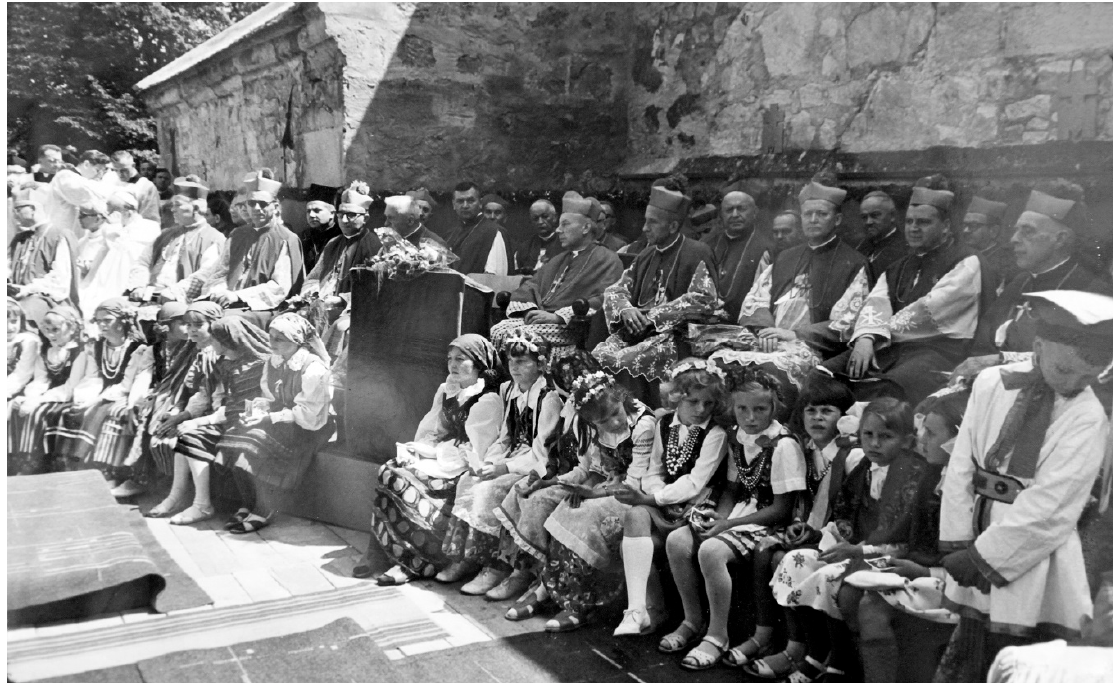
Figure 5. Celebrations of the coronation of the figure of the Mother of God of Wi ś lica (17 July 1966) (photo: Archives of the Sanctuary of Mother of God of Wi ś lica in Wi ś lica).